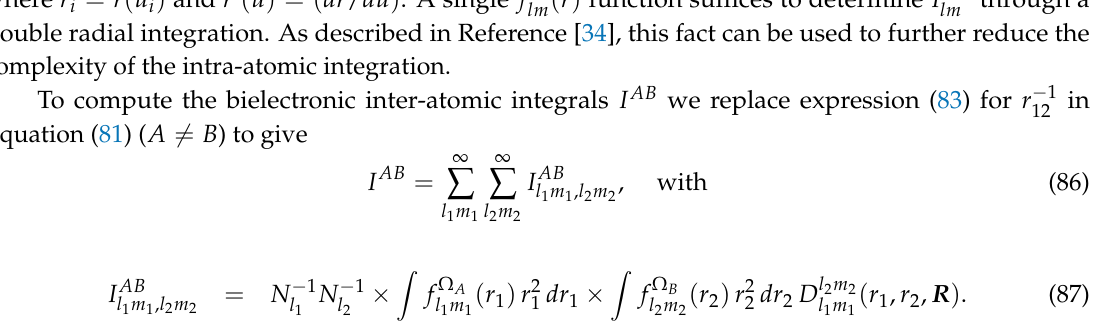
( r ) 1 , r 2 , R l 1 m 1